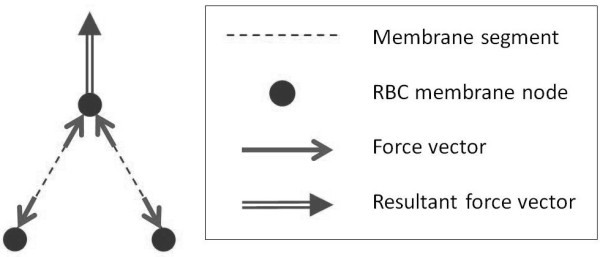
Schematic diagram of the internal forces in the membrane segments that gives rise to a resultant force at each membrane node. Under a combination of high compression and sharp curvatures between two membrane segments, the resulting force on the node shared between the segments can have a very large normal component, leading to an unrestricted “pinching” of the RBC membrane.